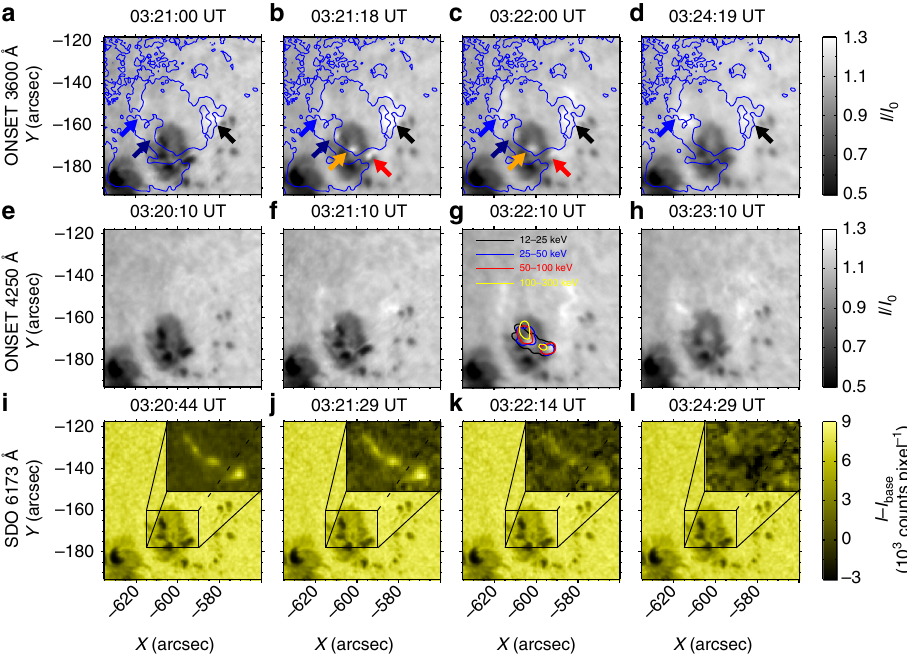
Fig. 1 Images of the white-light fl are around the fl are peak time. a – d ONSET 3600 Å images. e – h ONSET 4250 Å images. i – l SDO 6173 Å images. The fi eld of view of each panel is 75 ″ × 75 ″ . The arrows in a – d indicate the locations where the white-light emission occurred. Blue lines in a – d mark the polarity inversion line of the line-of-sight magnetogram. The RHESSI HXR contours of 40% the maximum intensity in the energy bands 12 – 25, 25 – 50, and 50 – 100 keV are overplotted in g at roughly the fl are peak time. The contour is 60% for the energy band 100 – 300 keV. The quantity I 0 in a – h refers to the background intensity in a nearby quiet region. The enlarged frames in i – l are the base-difference images of 6173 Å, relative to the base image at 03:19:59 UT. The counts in i – l are measured for each